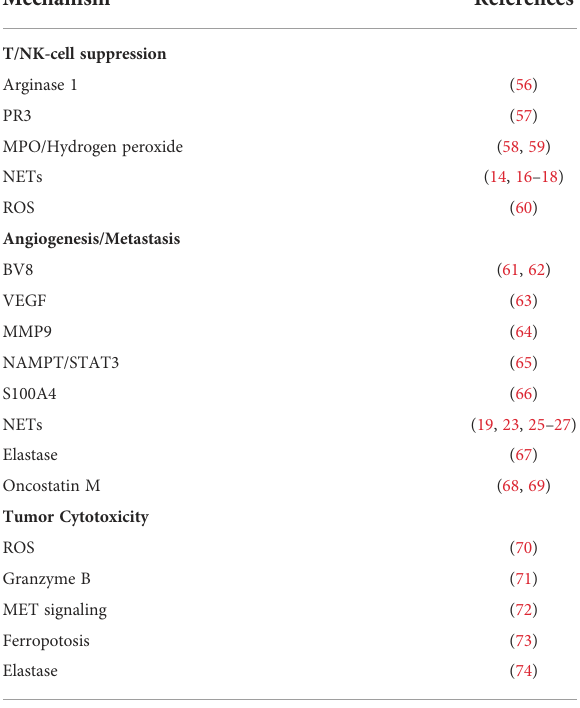
TABLE 1 Tumor-associated neutrophils (TANs) in tumors.